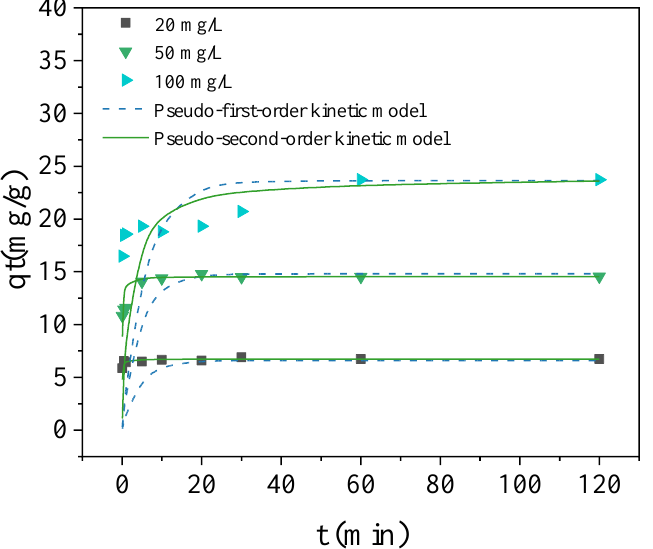
Figure 9. Adsorption kinetics fitting curves (T = 293 K, m/V = 3 g · L − 1 , and pH = 7.0).